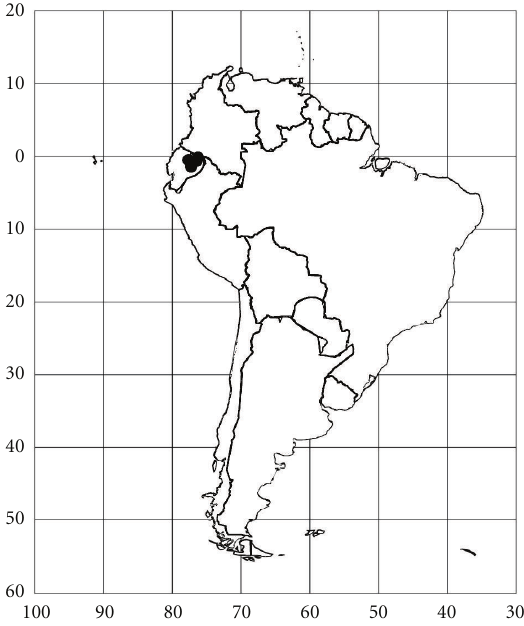
Figure 8: Head of a paratype male of C. reburrus .